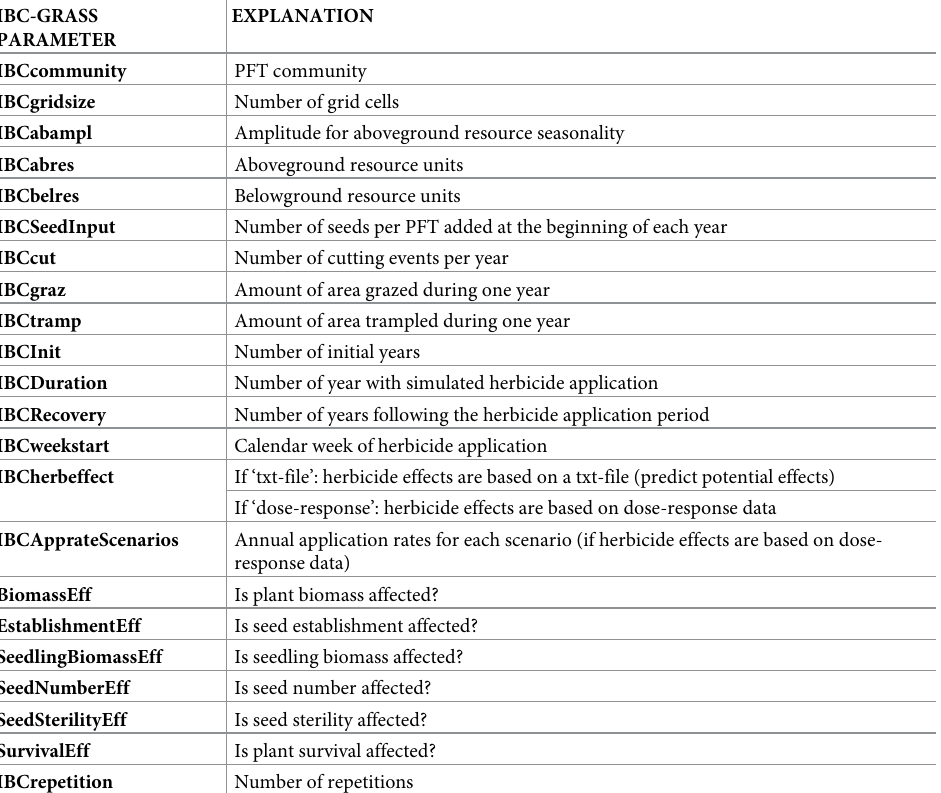
Table 3. Model parameters addressed in the